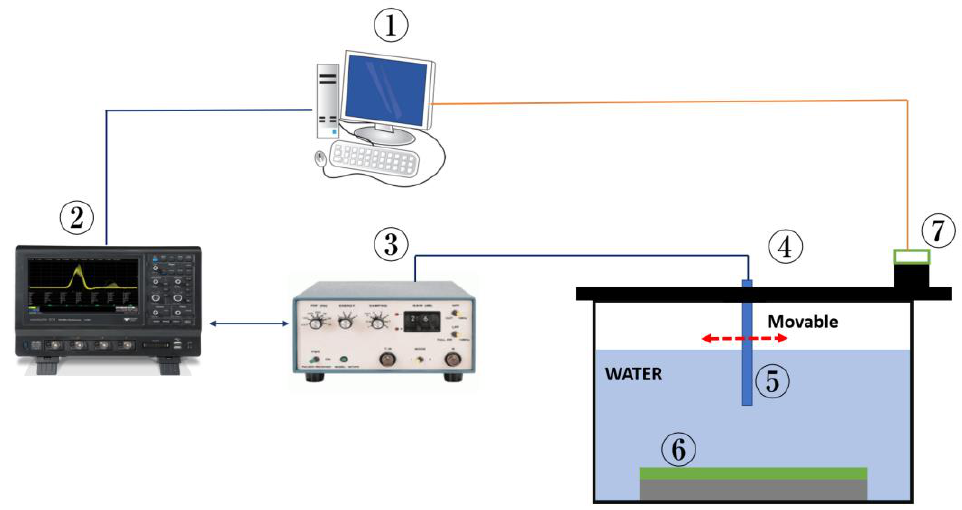
Figure 3. Instrumental setup: ① Computer, ② Lecroy Oscilloscope, ③ Pulser – receiver, ④ Ultrasonic probe, ⑤ Immersion scanning tank, ⑥ Coated concrete specimen, and ⑦ Probe positioning unit.